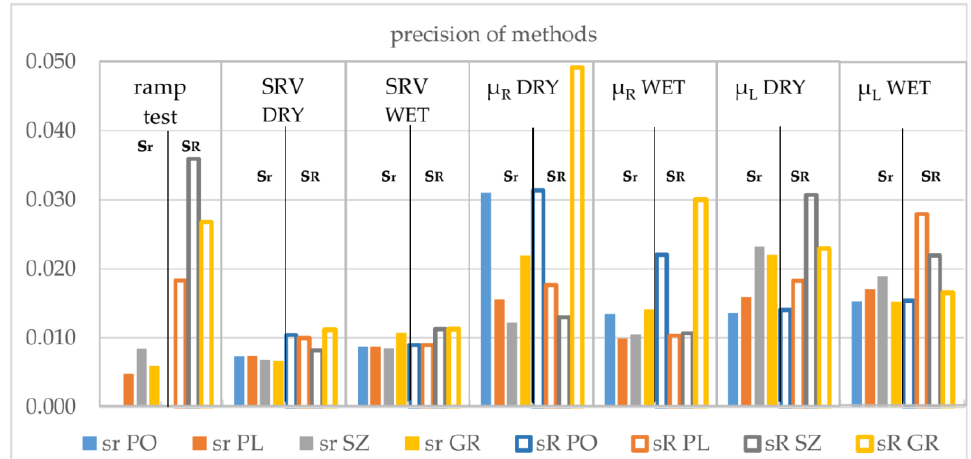
Figure 12. Precision of methods: repeatability standard deviation (s r ) and reproducibility standard deviation (s R ) for ramp test, test of SRV for dry and wet surfaces, sliding friction coefficient using rubber slider (µ R ), and sliding friction coefficient using leather slider (µ L ) for dry and wet surfaces. The values of s r and s R were obtained from the results subjected to quotient transformations (maximal values for each test method were used as normalizing values).